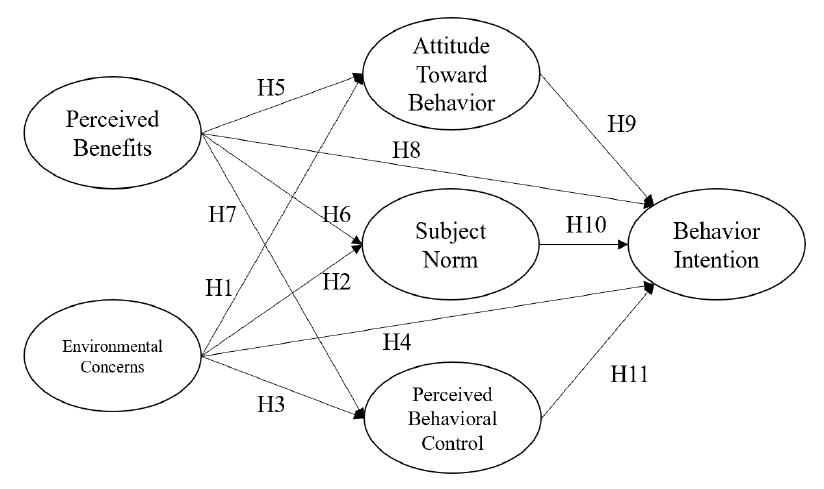
Figure 1. Research structure.